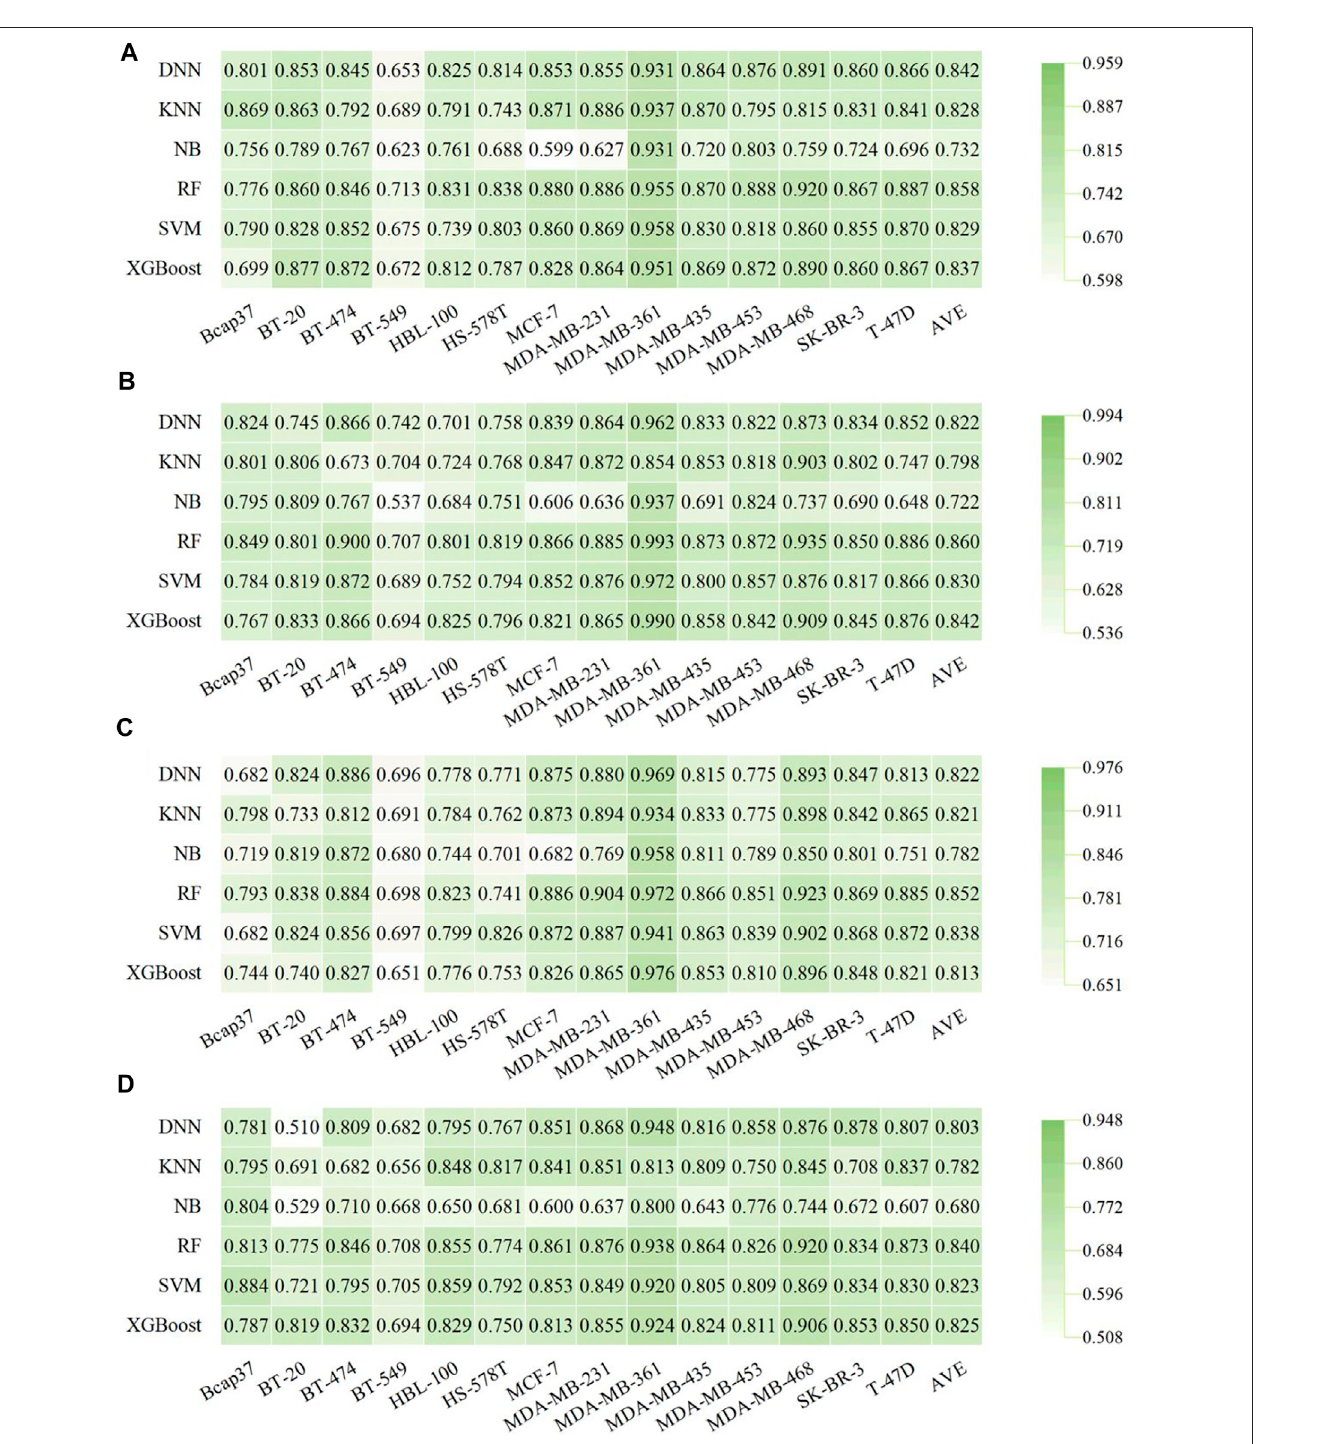
Frontiers in Pharmacology |